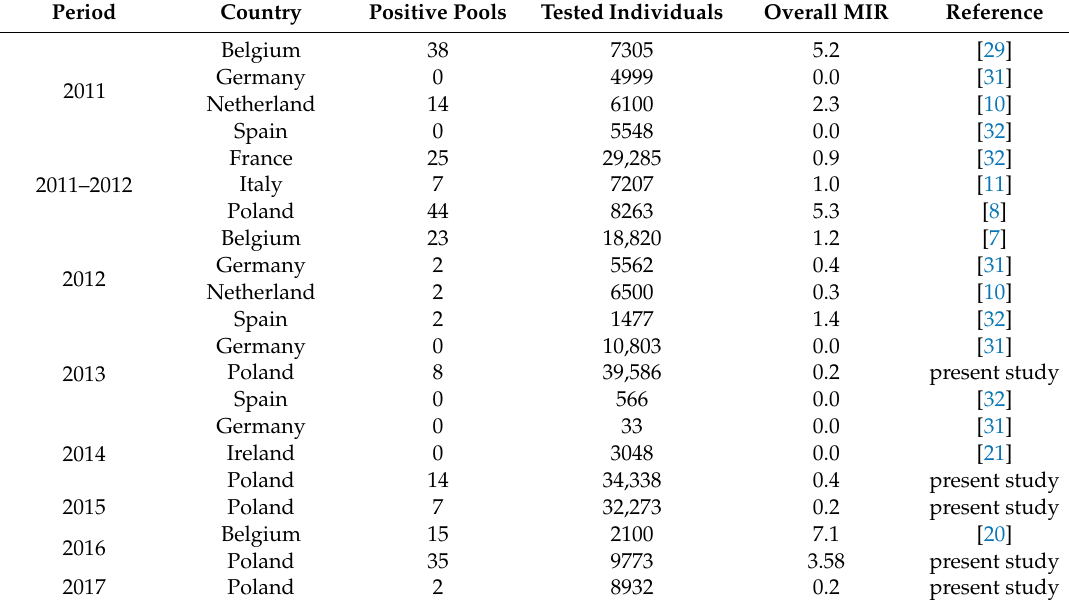
Table 3. Summary of the overall minimum infection rate (MIR) in Culicoides from di ff erent studies calculated as the number of positive pools (heads or whole insects) divided by the overall number of tested midges from all tested species, parity statuses, and locations multiplied by